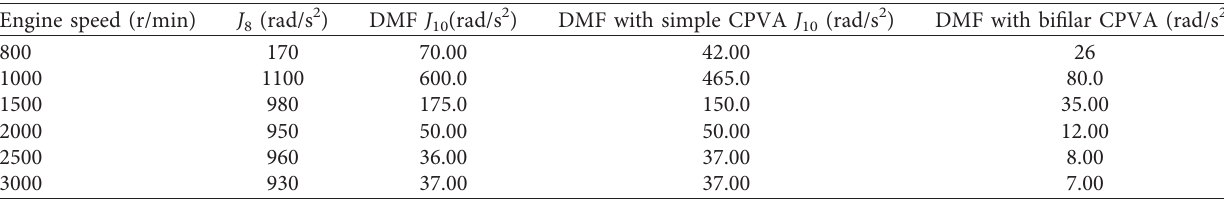
Table 5: The 2 nd order angular acceleration amplitudes corresponding to different rotational speeds. Engine speed